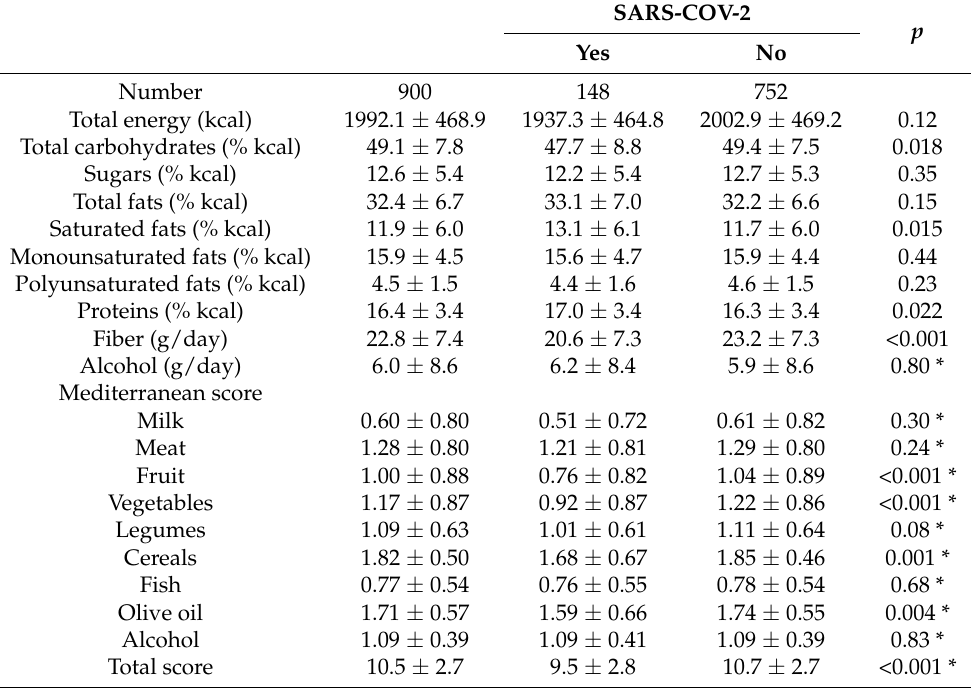
Table 2. Dietary habits of the